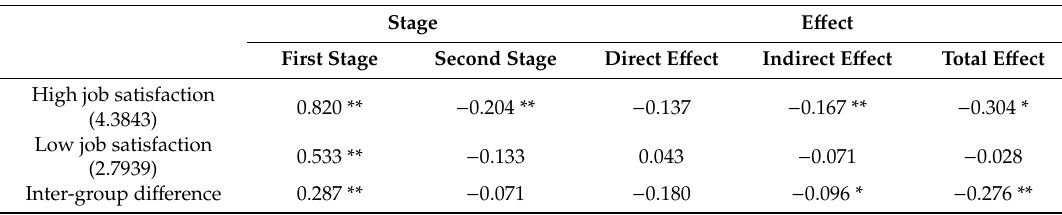
Table 4. Results of moderated mediation e ff ect.